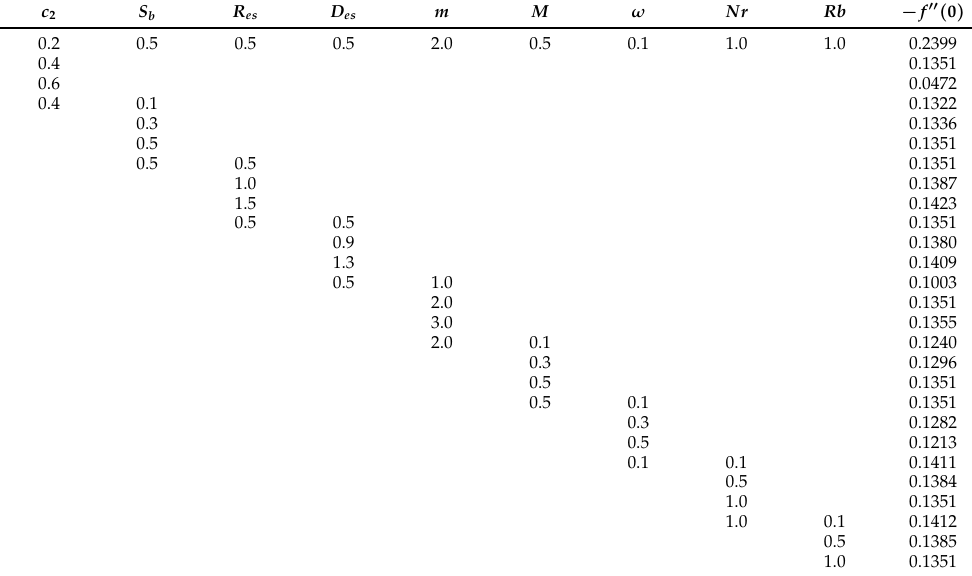
Table 2. Results for − f (cid:48)(cid:48) ( 0 )